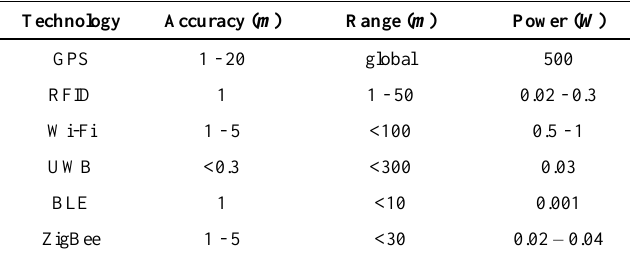
Table 1. RF-based indoor localization